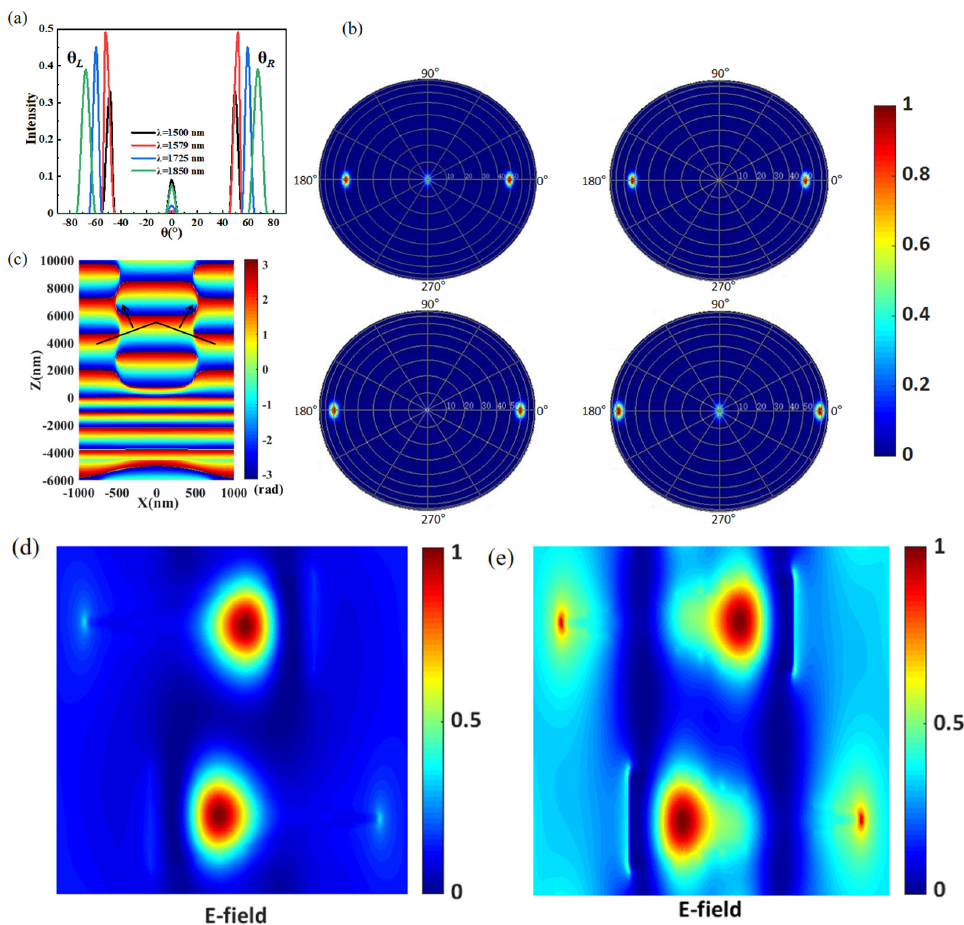
Figure 4. ( a ) Far-field transmitting intensities for different anomalous refraction angles and ( b ) the angular distributions of transmitted light at 1500, 1579, 1725, and 1850 nm wavelengths. ( c ) Phase distribution in the x-z plane at the wavelength of 1579 nm. ( d ) Electric field distribution at the wavelength of 1500 nm. ( e ) Electric field distribution at the wavelength of 1579 nm.